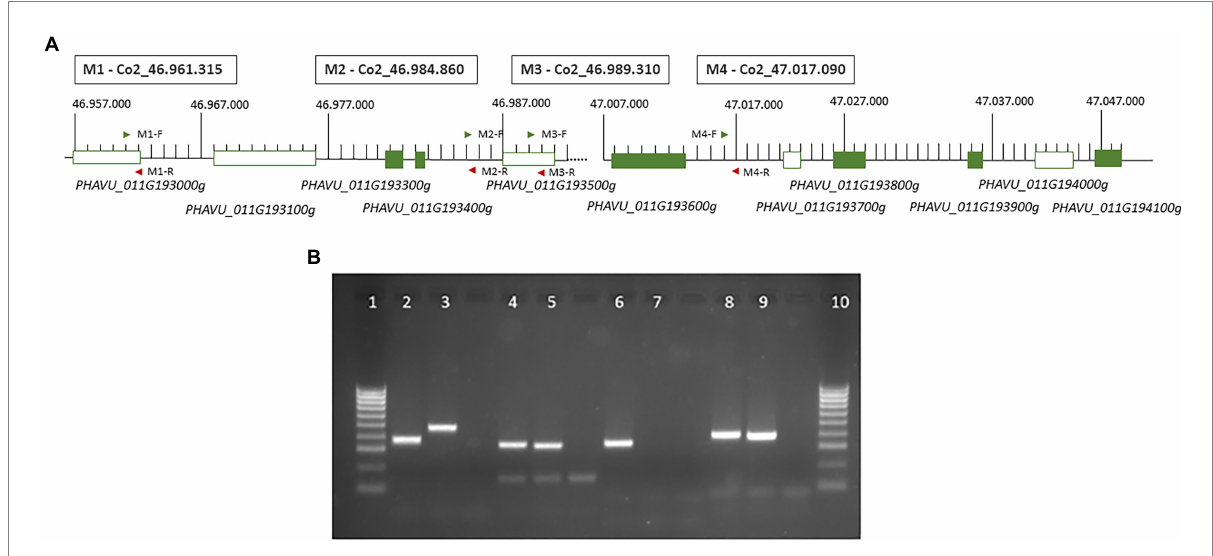
FIGURE 4 (A) Representation of the ‘core region’ with the 6 annotated genes in the reference genome and the position of the four markers developed in this study. Green boxes represent candidate genes revealed in transcriptomic analysis (Figure 3). (B) Agarose gel (2%) showing the results of the PCR amplification for the four markers developed: lines 1 and 10, marker 100 bp; 2 and 3, results in n A25 and A4804 for the marker M1_ Co2_46.961.315; 4 and 5, results in A25 and A4804 for the marker M_ Co2_46.984.860; 6 and 7, results in A25 and A4804 for the marker M3_ Co2_46.989.310; 8 and 9, results in A25 and A4804 for the marker M4_